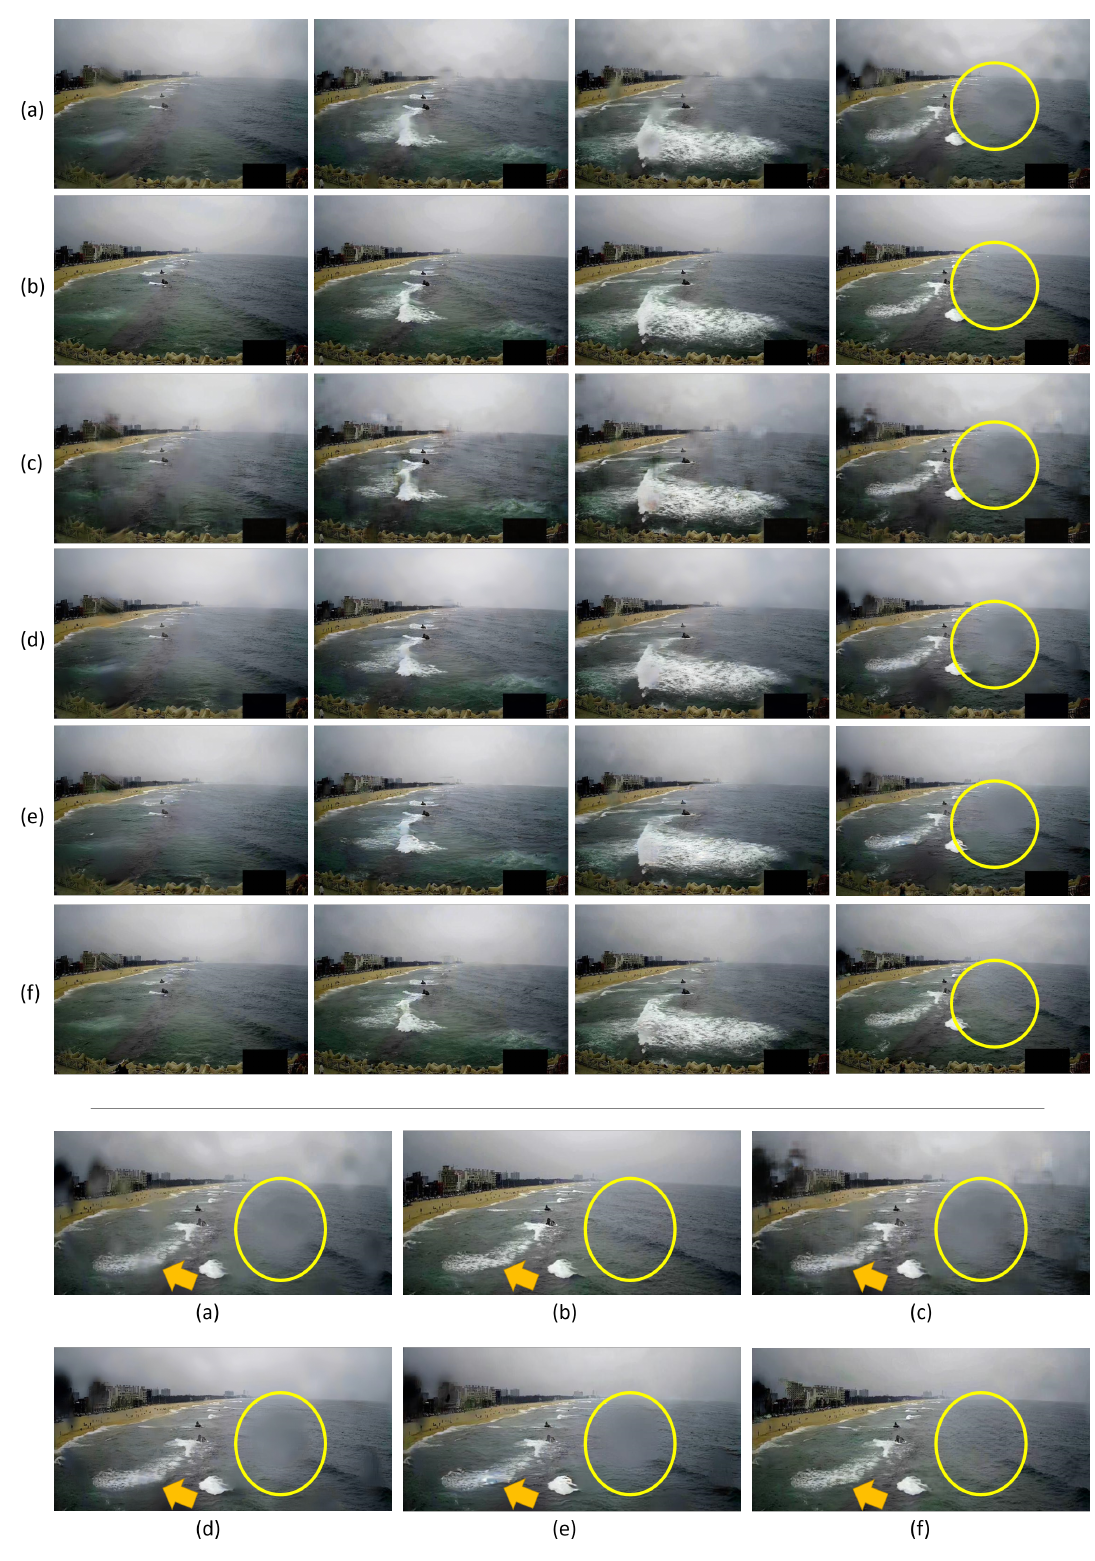
Figure 8. Test examples from the Anmok paired dataset : ( a ) distorted examples; ( b ) their corresponding clean images; and the reconstruction results of ( c ) Pix2Pix ; ( d ) Attentive GAN ; ( e ) pre-trained Raindrop-aware GAN ; and ( f ) fine-tuned Raindrop-aware GAN . The right most examples are displayed in larger size in bottom rows. Circles and arrows indicate areas of steep wave crests and breaking,